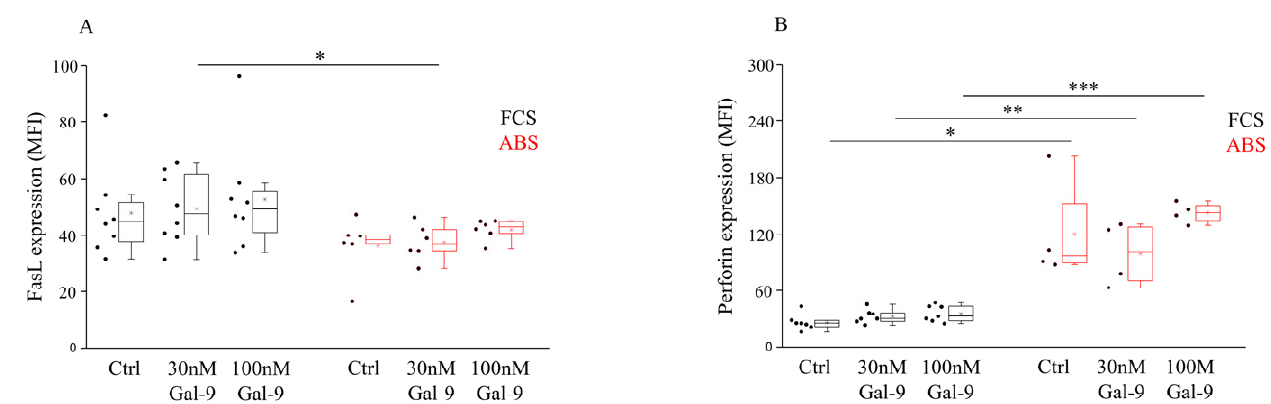
Figure 3. Surface FasL and intracellular perforin expression by NK-92MI cell line cultured in medium supplemented with FCS or human ABS and after recombinant Gal-9 treatment. The cell surface FasL ( A ) expression and intracellular perforin content ( B ) of NK-92MI cells following 30 and 100 nM Gal-9 addition, cultured in medium supplemented with 10% FCS or 10% human ABS. The solid bars represent medians of 10 determinations, the boxes indicate the interquartile ranges, and the lines show the most extreme observations. Differences were considered statistically significant for p -values * < 0.05; ** < 0.03; *** <